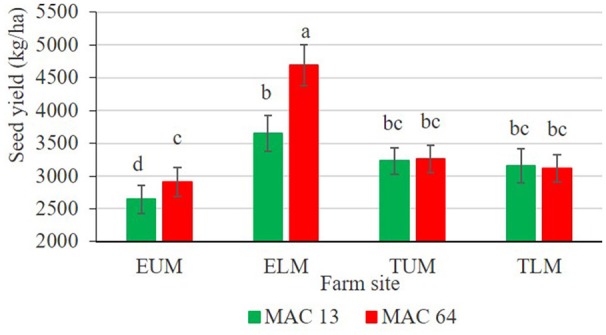
Interactive effects of bean variety with farm site on seed yield of climbing beans. Bars followed by the same letter are not significantly different according to Tukey's HSD test at P ≤ 0.05. ELM, Embu Lower Midland; EUM, Embu Upper Midland; TLM, Tharaka Nithi Lower Midland; TUM, Tharaka Nithi Upper Midland.